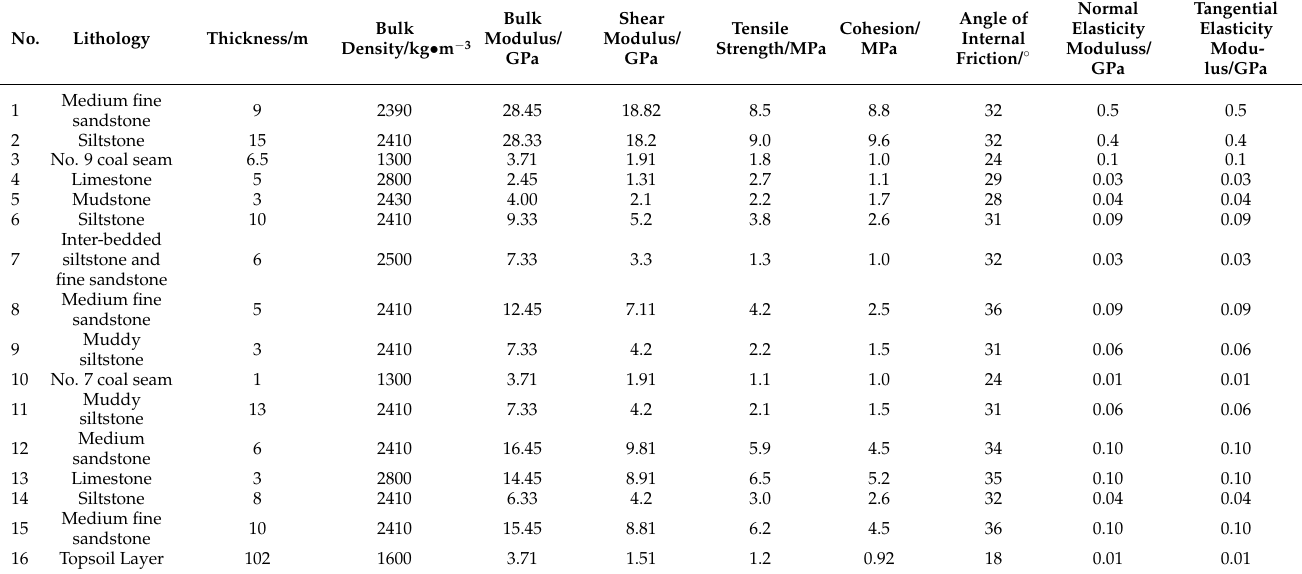
Table 3. Rock parameters and contact surface parameters of the 11915 working